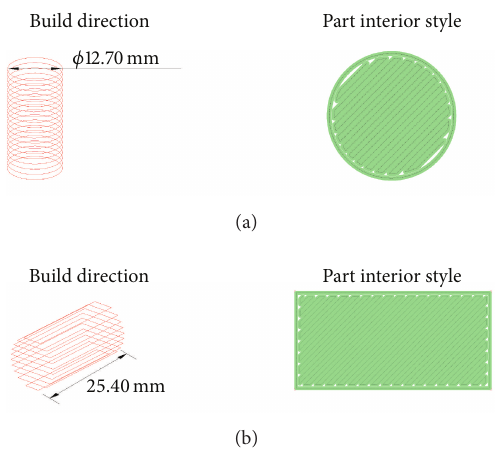
Figure 2: Build direction and part interior style of cylindrical test specimens: (a) transverse-vertical and (b) horizontal-axial configurations. Table 1: System specifications of FDM machine.